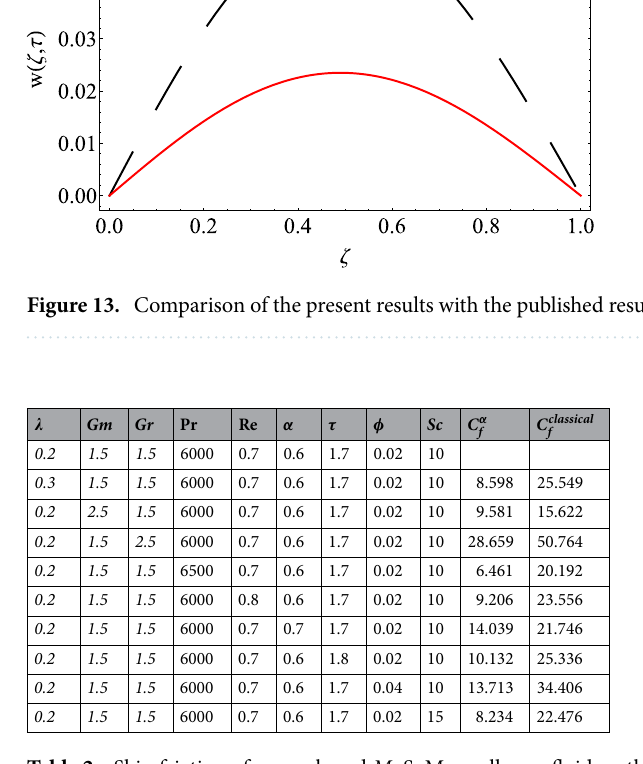
Table 2. Skin friction of grease based MoS 2 Maxwell nanofluid on the left plate.